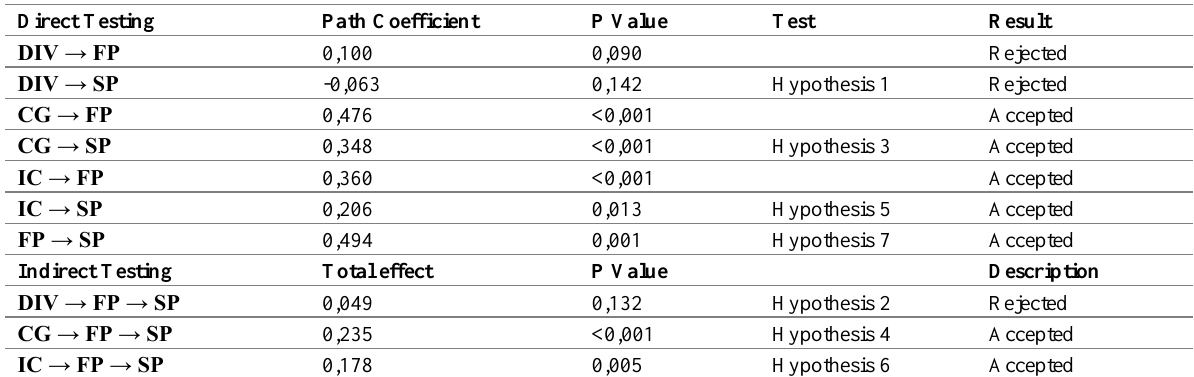
Table 1: Hypothesis Testing